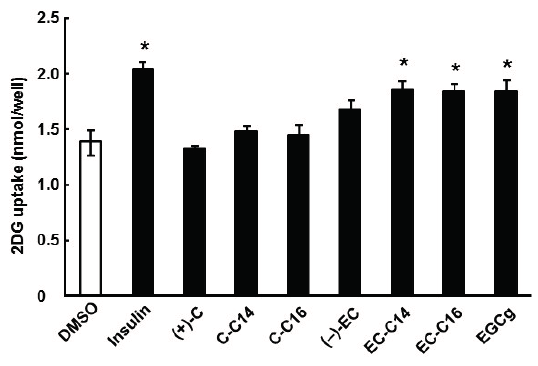
Figure 2. The effects of 3- O -acyl-catechins on glucose uptake activity in L6 myotubes. Differentiated L6 cells were incubated with 100 nM catechins and 3- O -acyl-catechins for 15 min. Glucose uptake activity was measured using [ 3 H]-2DG as described in the Experimental Section. Data are shown as the mean ± SE ( n = 3). * p < 0.05 vs. DMSO-treated control cells (Dunnett multiple comparison